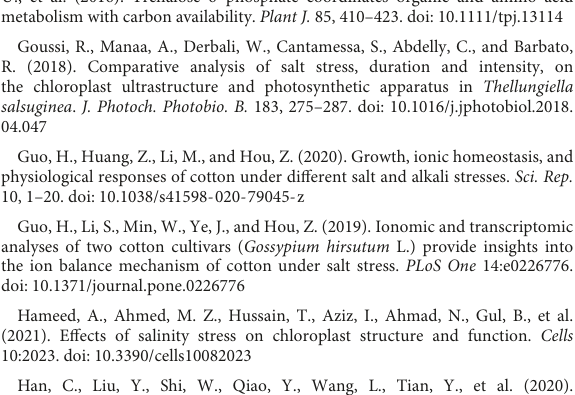
Figueroa, C. M., and Lunn, J. E. (2016). A tale of two sugars: Trehalose 6-phosphate and sucrose. Plant Physiol. 172, 7–27. doi: 10.1104/pp.16.00417 Figueroa, C. M., Feil, R., Ishihara, H., Watanabe, M., Kölling, K., Krause, U., et al. (2016). Trehalose 6–phosphate coordinates organic and amino